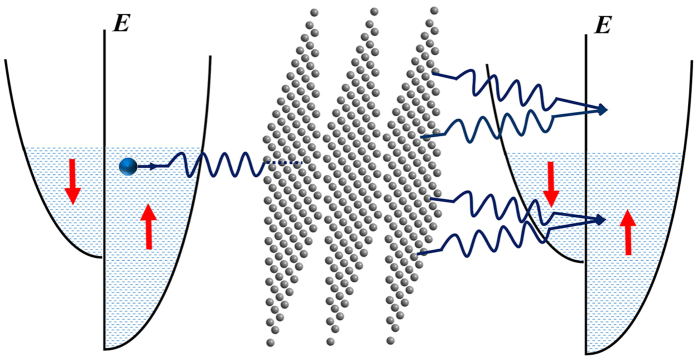
The diagrammatic sketch of the diffraction process where the incident electron is spin-up.